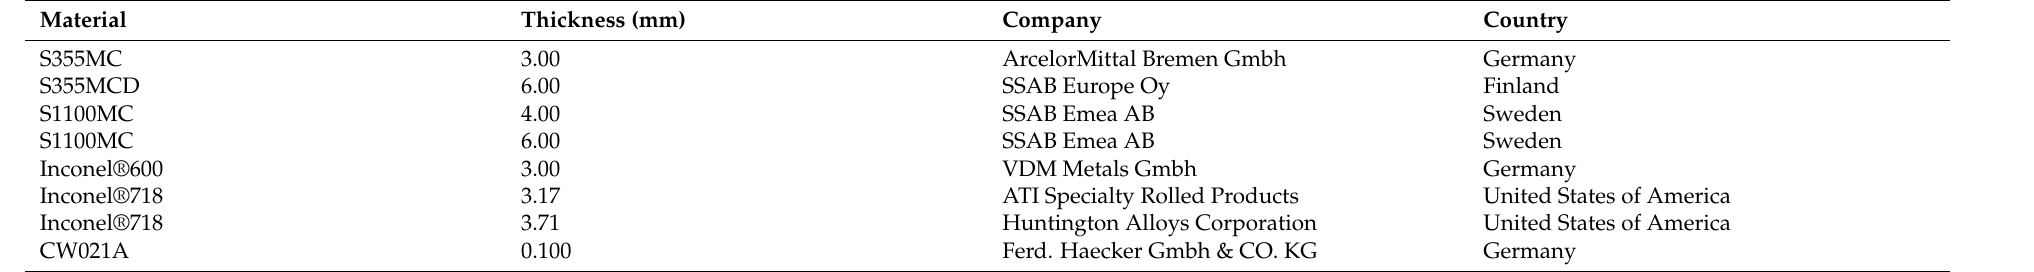
Table A2. Material manufacturers and